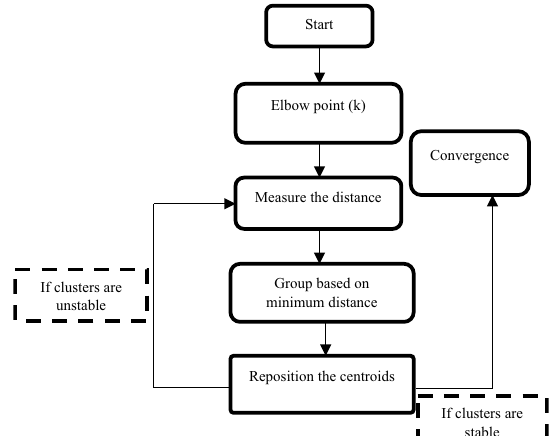
Fig. 2 Flowchart of K -means algorithm